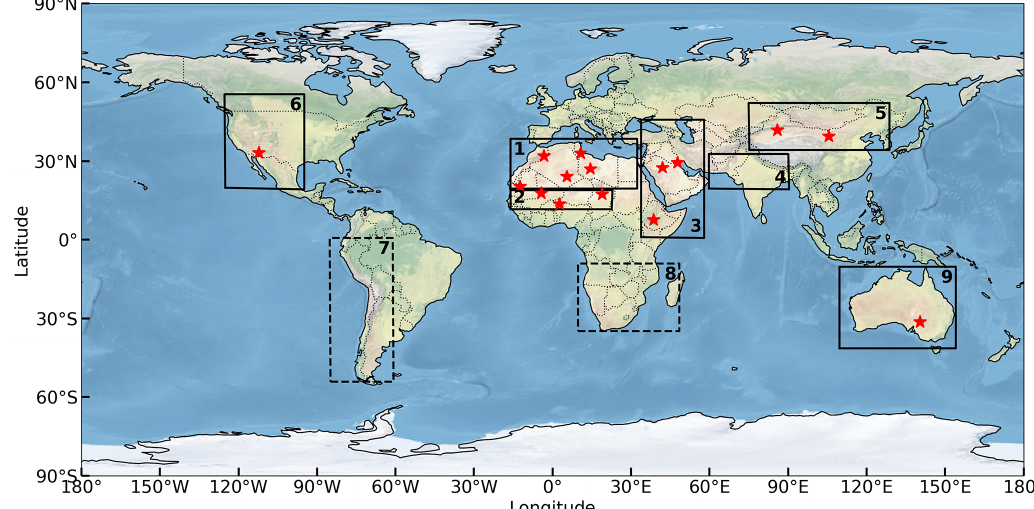
Figure 4. The nine main global dust-source regions: (1) northern Africa, (2) the Sahel, (3) East Africa and the Middle East, (4) Central Asia, (5) East Asia, (6) North America, (7) South America, (8) southern Africa, and (9) Australia. From the eight regions originally selected by Ginoux et al. (2012), North Africa was divided into northern Africa and the Sahel (Di Biagio et al., 2017). MAIAC EPIC version 2 does not provide dust aerosol data over regions 7 and 8 (rectangular boxes with dashed lines). The 15 red stars denote locations of Di Biagio et al. (2019) collected soil samples which were analyzed for the iron-oxide content, complex refractive indices, and SSA using laboratory measurements of aerosol generated from these